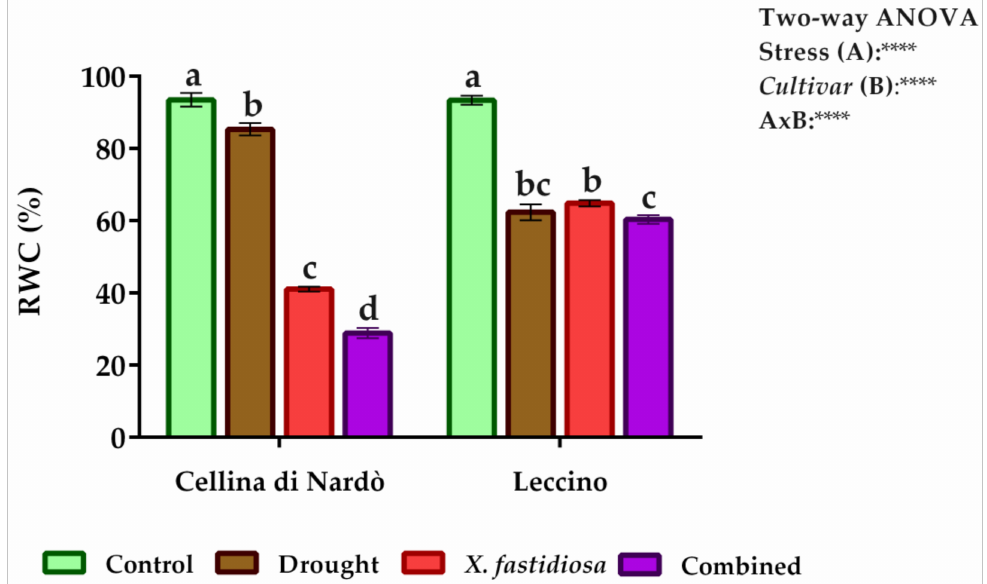
Figure 1. Relative water content (RWC) determined on Cellina di Nard ò and Leccino fully expanded leaves subjected to individual and combined stresses (drought and Xylella fastidiosa ). Top right Two-way ANOVA results were reported. Di ff erent letters correspond to statistically di ff erent